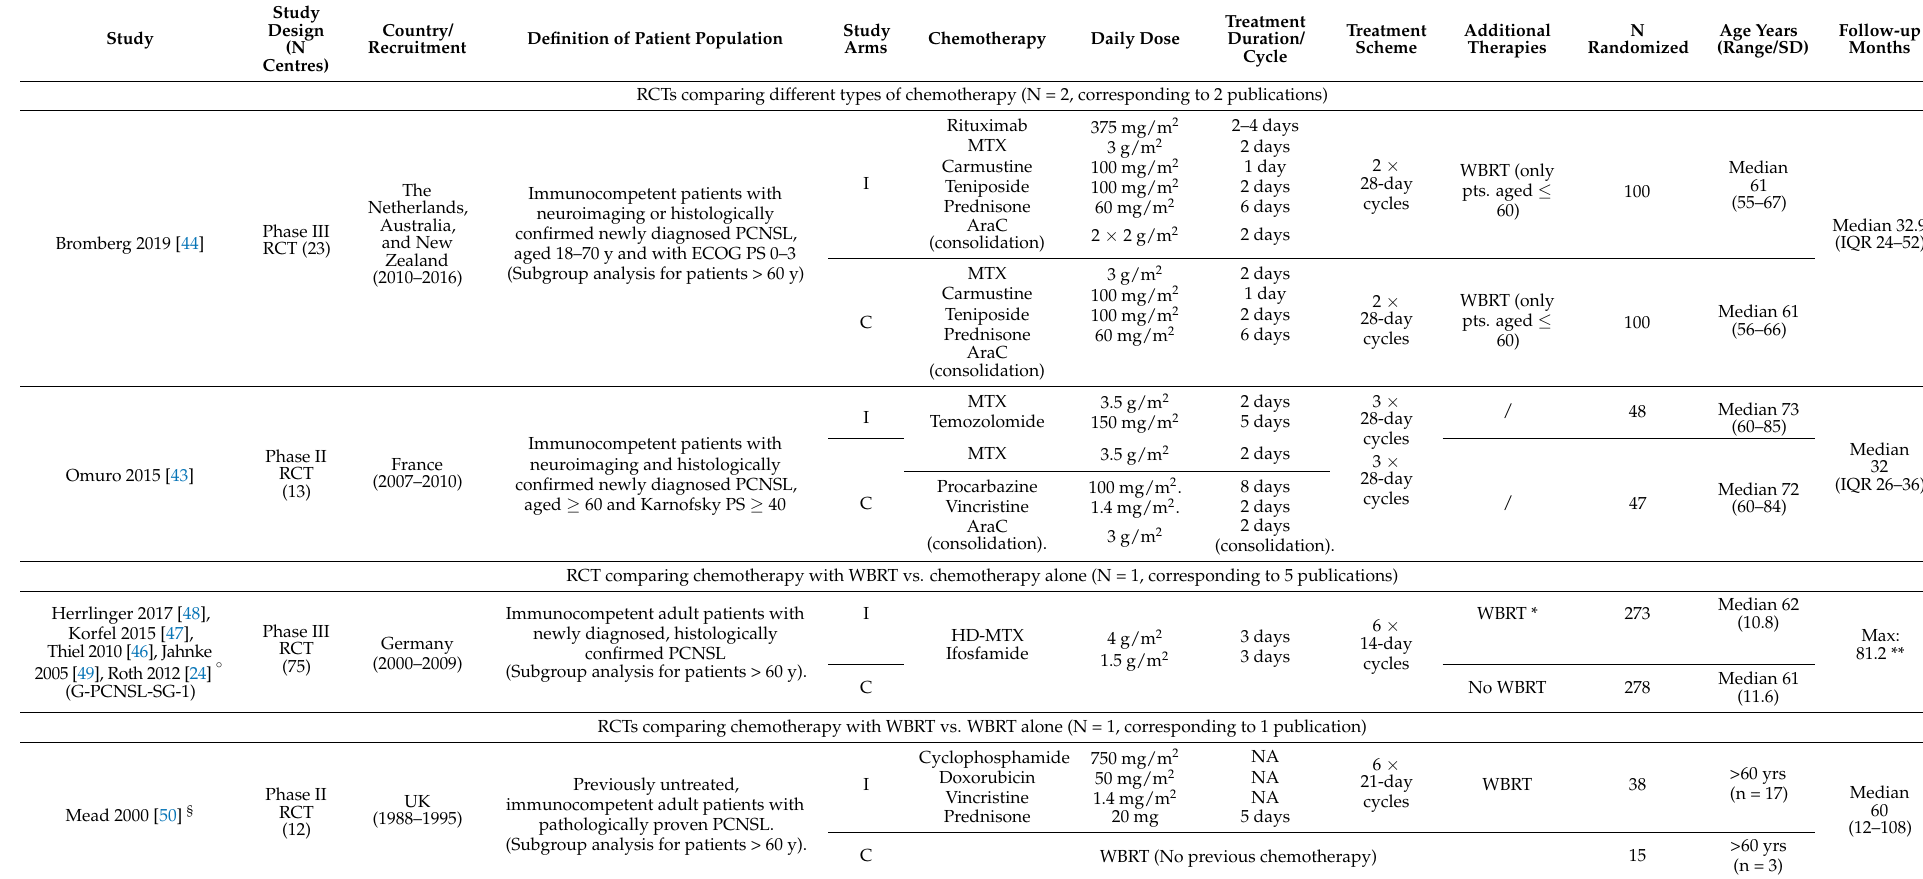
Table 1. Key characteristics of randomized controlled